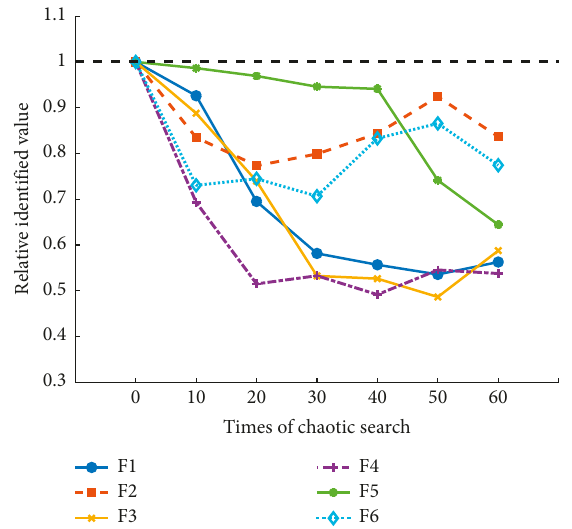
Figure 6: Influences of the times of chaotic search for TCABC algorithm.